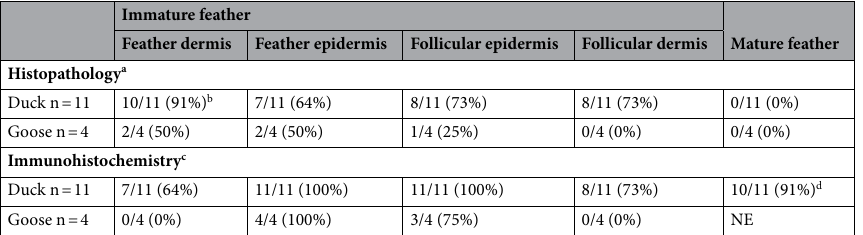
Table 1. Proportion of naturally H5N8-infected ducks and geese with histopathological lesions and positive viral detection in immature and mature feathers. NE non evaluated. a Focal to extensive lytic necrosis and apoptosis/single cell necrosis in epidermal structures. Mixed leukocytic lympho-plasmacytic rich infiltration in dermal structures. b Total number of positive subjects / Total subjects (percentage of positive subjects). c